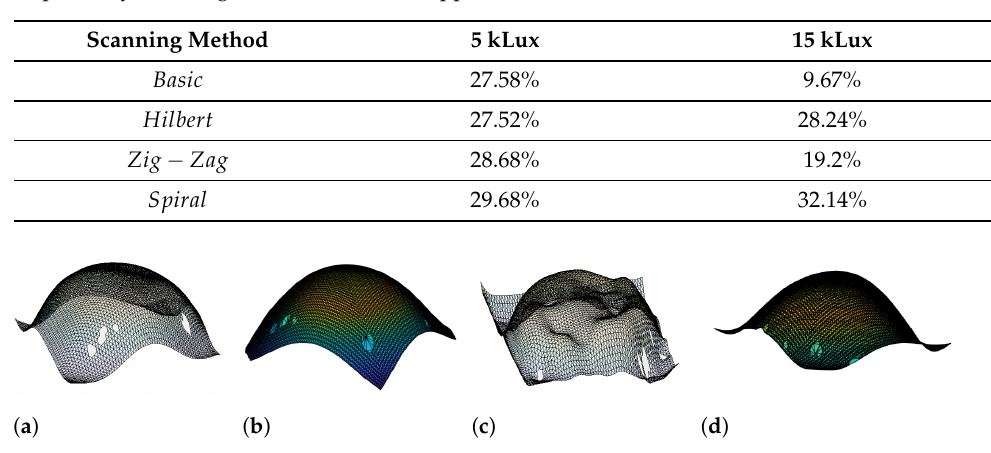
Figure 11. Reconstructed3D mesh improving at a distance of 20 cm from the focal lens, using different scanning techniques under foggy conditions with particles’ size of 3 µ m and background light of 5 and 15 kLux, respectively: ( a ) 50 mm diameter spherical, ( b ) cube with dimensions of 40 mm × 40 mm × 40 mm, ( c ) torus (ring-like object) with an external diameter of 55 mm and an internal diameter of 25 mm, and ( d ) U-shaped object with dimensions of 65 mm × 40 mm × 17 mm. Table 3. Improvement rate expressed through RMSE Equation (17) of the reconstructed 3D image under foggy conditionss with particle diameter of 3 µ m and background light of 5 and 15 kLux, respectively, after Algorithm A3 has been applied.